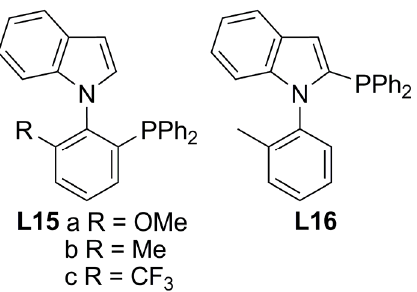
Figure 4. C-N bond axially chiral